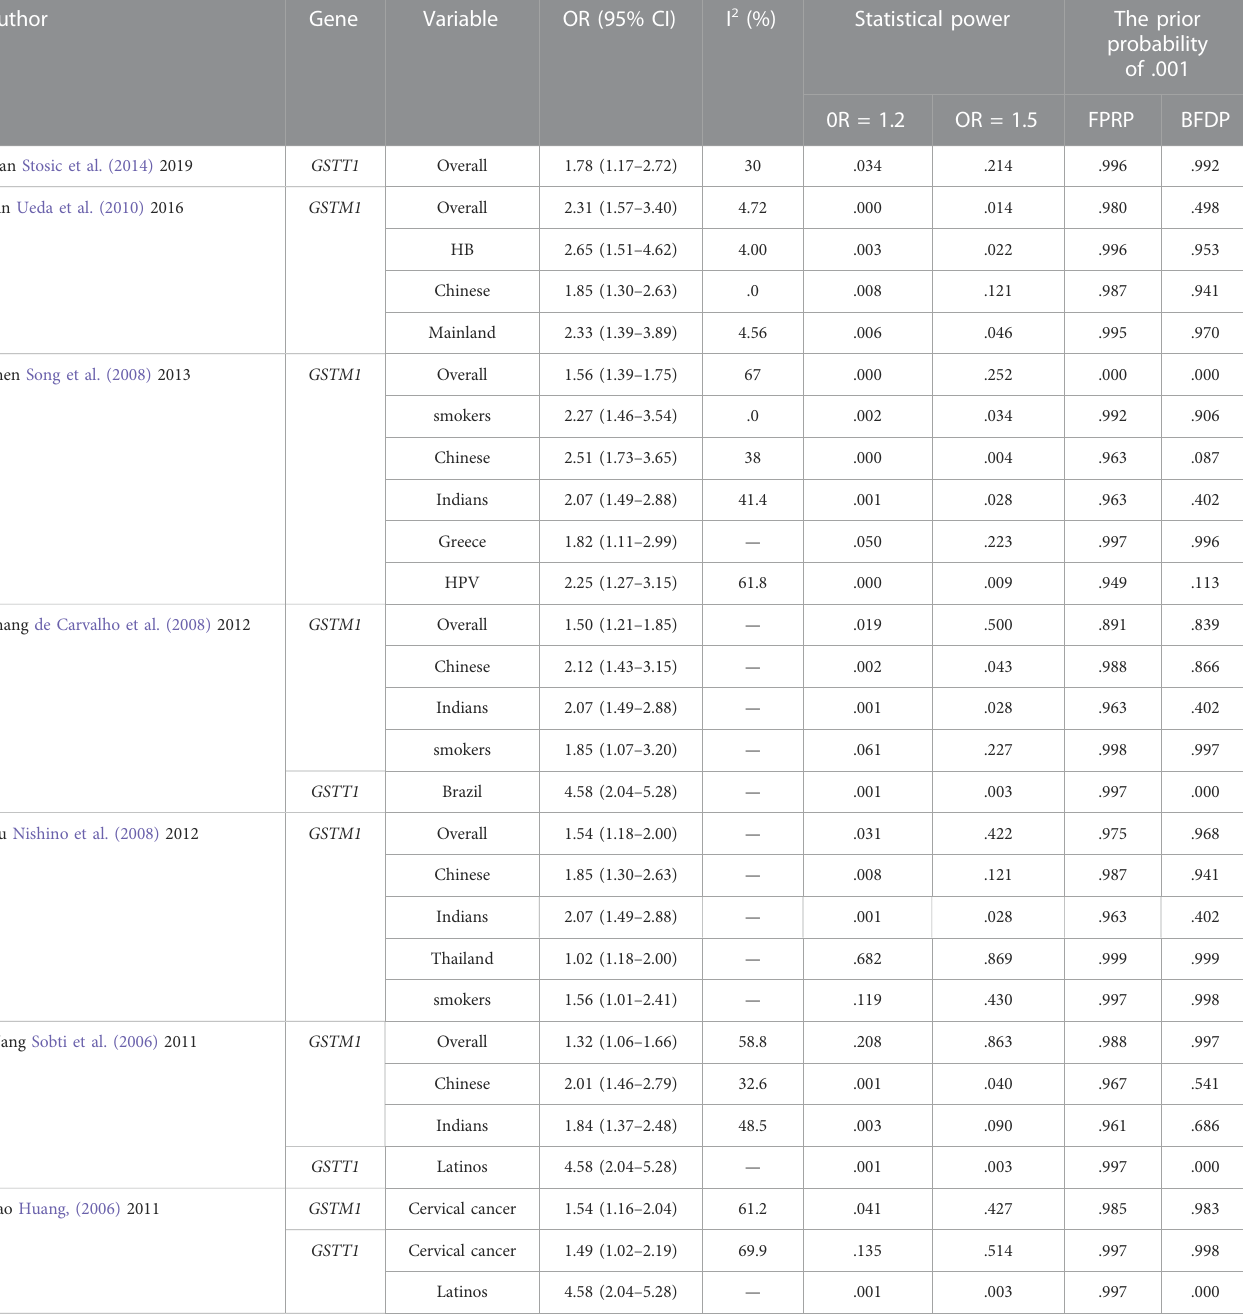
TABLE 11 Con fi dence analysis of positive results from previously published